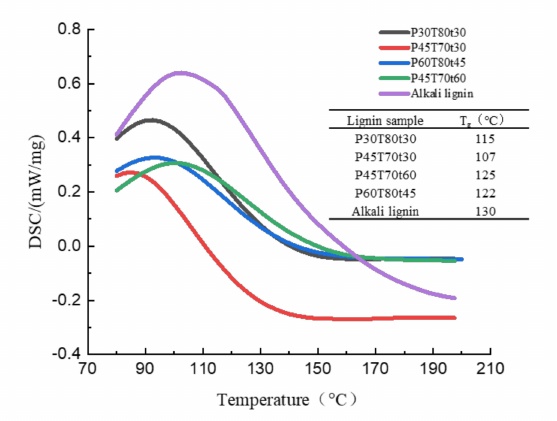
Figure 10. DSC profile and T g of lignin